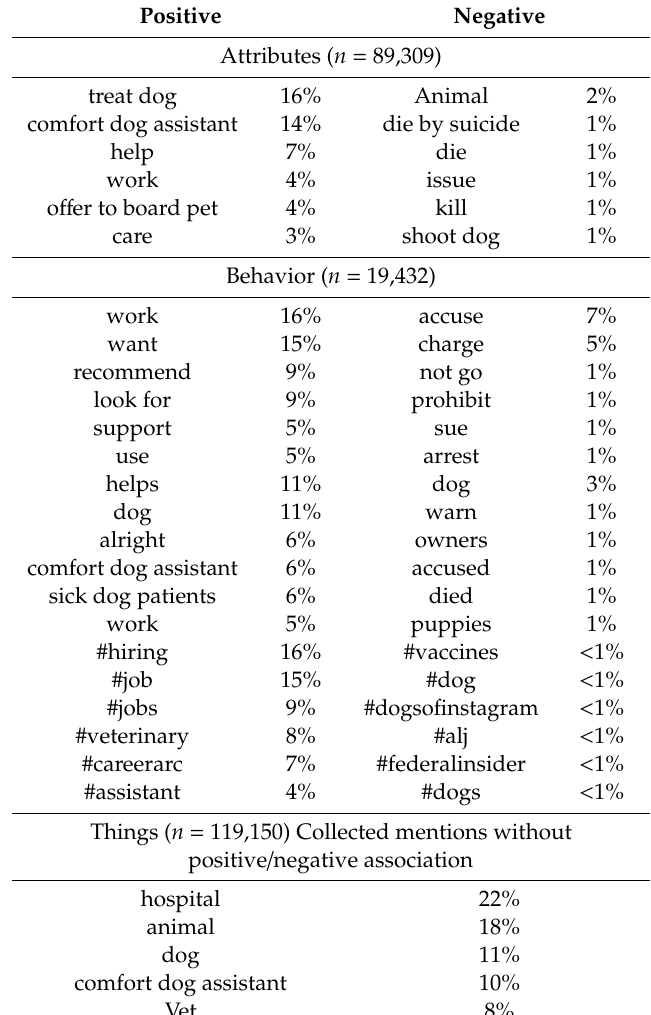
Table 4. Top five positive and negative sentiment drivers for di ff erent word